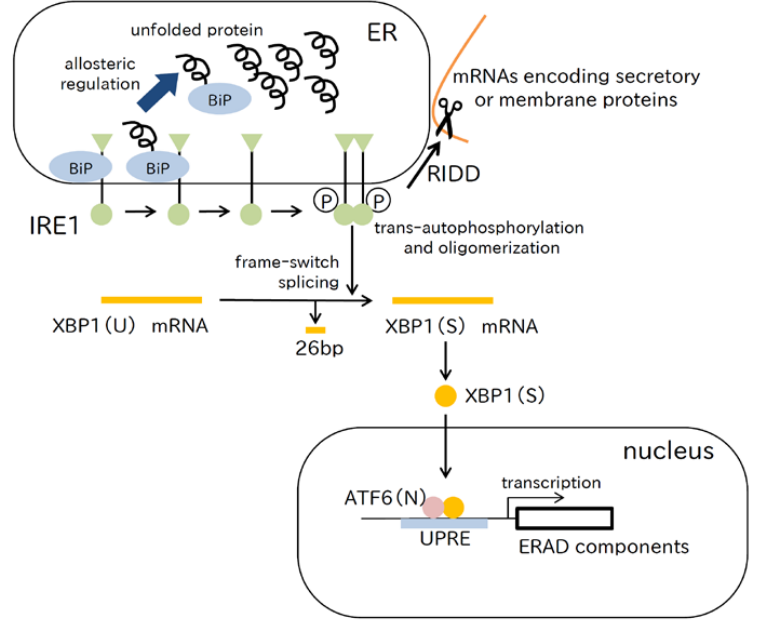
Figure 3. The IRE1 pathway. Using the allosteric model of UPR induction, the mechanism of